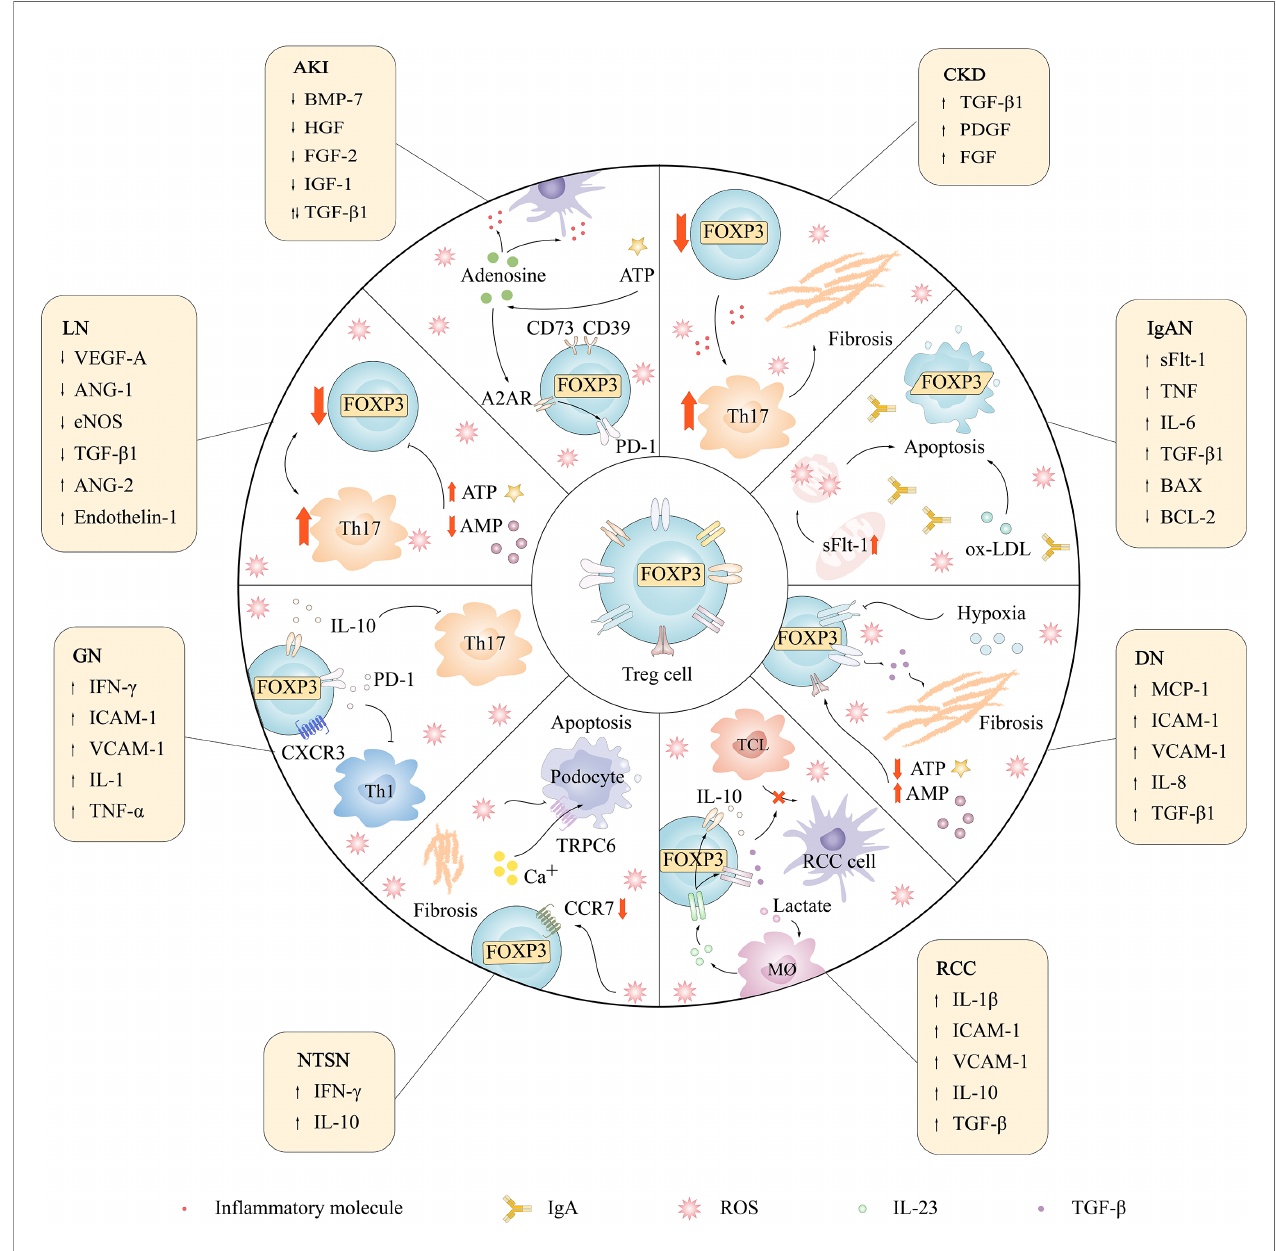
FIGURE 5 | The relationship between Treg cells and renal diseases and changes of